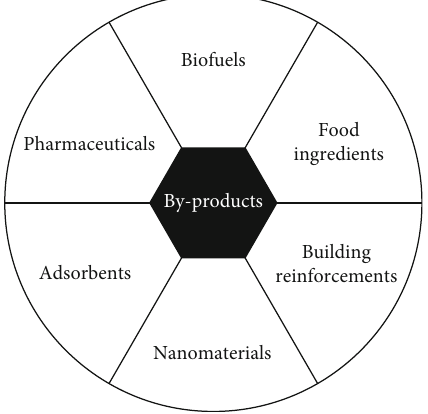
Figure 3: Potential application of